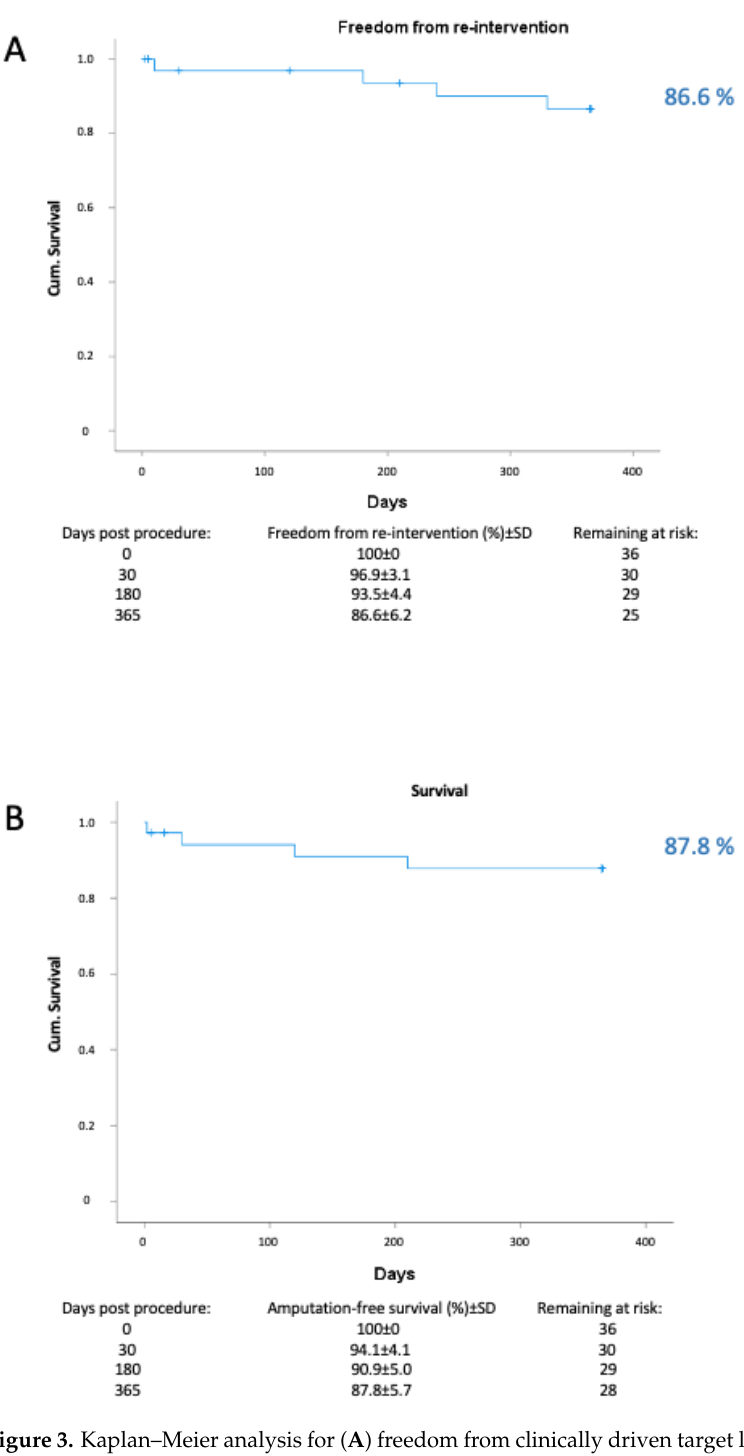
Figure 3. Kaplan–Meier analysis for ( A ) freedom from clinically driven target lesion revascularization (cd TLR) and ( B ) survival.